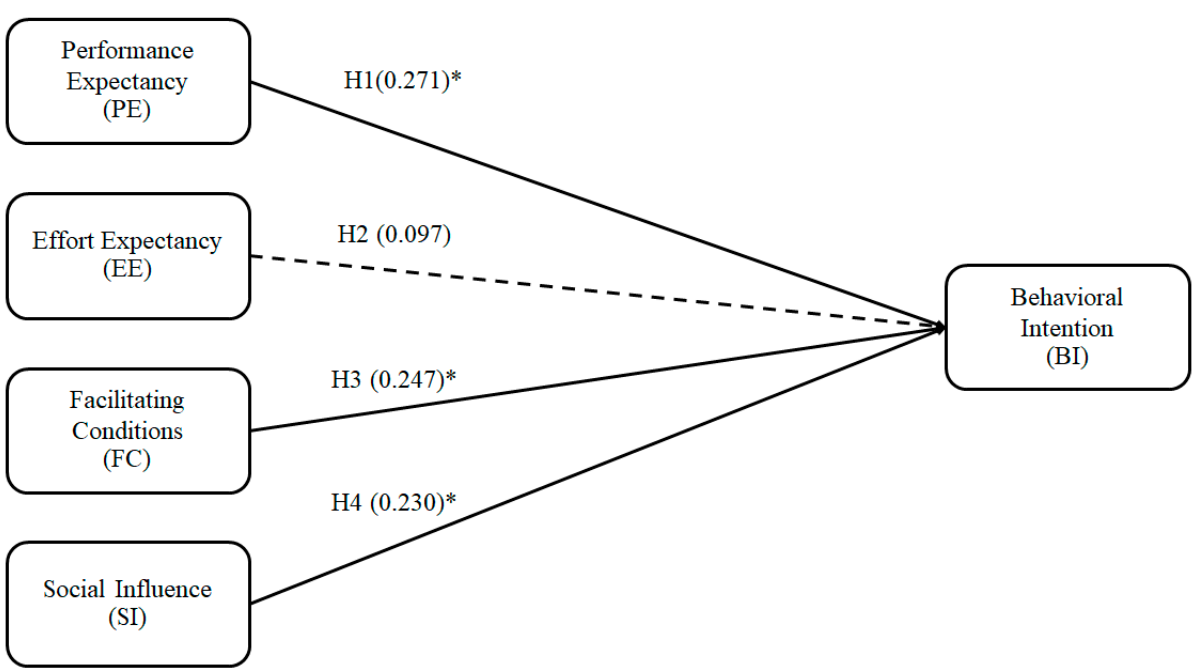
Figure 2. Structural model. Note: * Significance < 0.05(Source: figure created by authors 2023.)